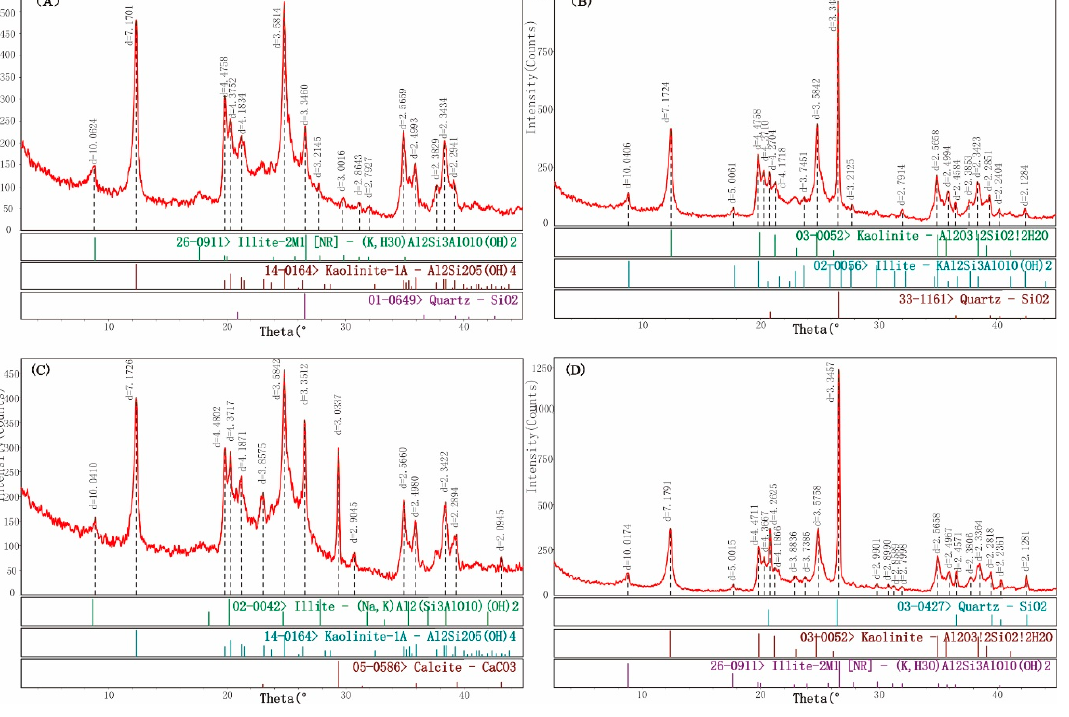
Figure 8. XRD patterns of samples from Hebi No. 6 coal seam. ( A ) Sample HB-19; ( B ) sample HB-21; ( C ) sample HB-23; ( D ) sample HB-24.